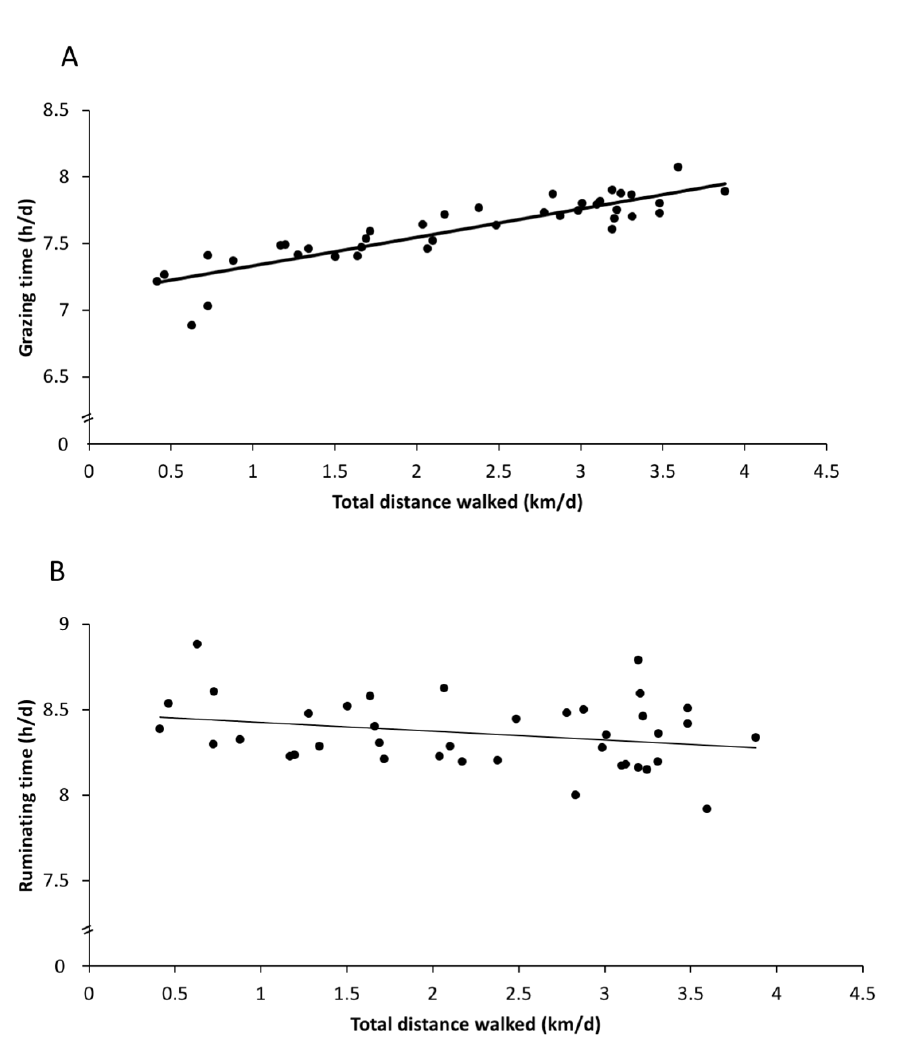
Figure 2. Regression analysis of the total distance walked against behaviours in the paddock. ( A ) Grazing time increased with the distance walked, and ( B ) ruminating time decreased with the distance walked. The predicted values from the regression models are plotted for each of the 13 days for the 3 groups.